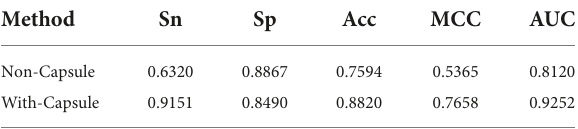
TABLE 3 Predictive performance of the method without capsule